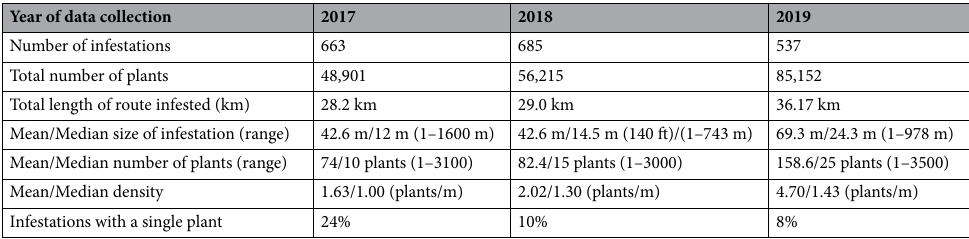
Table 1. Descriptions of infestations across the study time